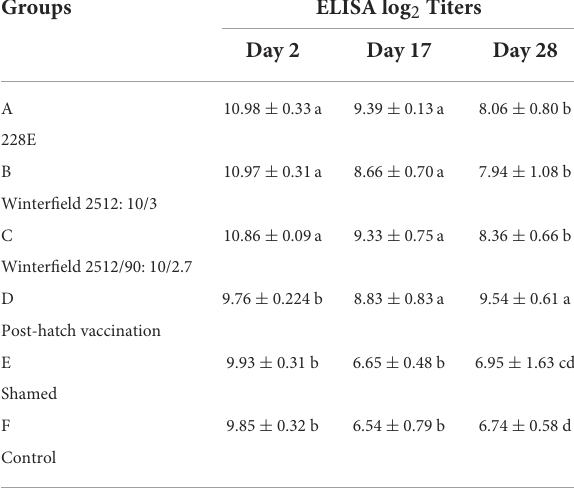
TABLE 4 Lymphoproliferative response against PHA-P in White Leghorn chicks administered IBD live vaccines by in ovo and post-hatch (mean ± SD).